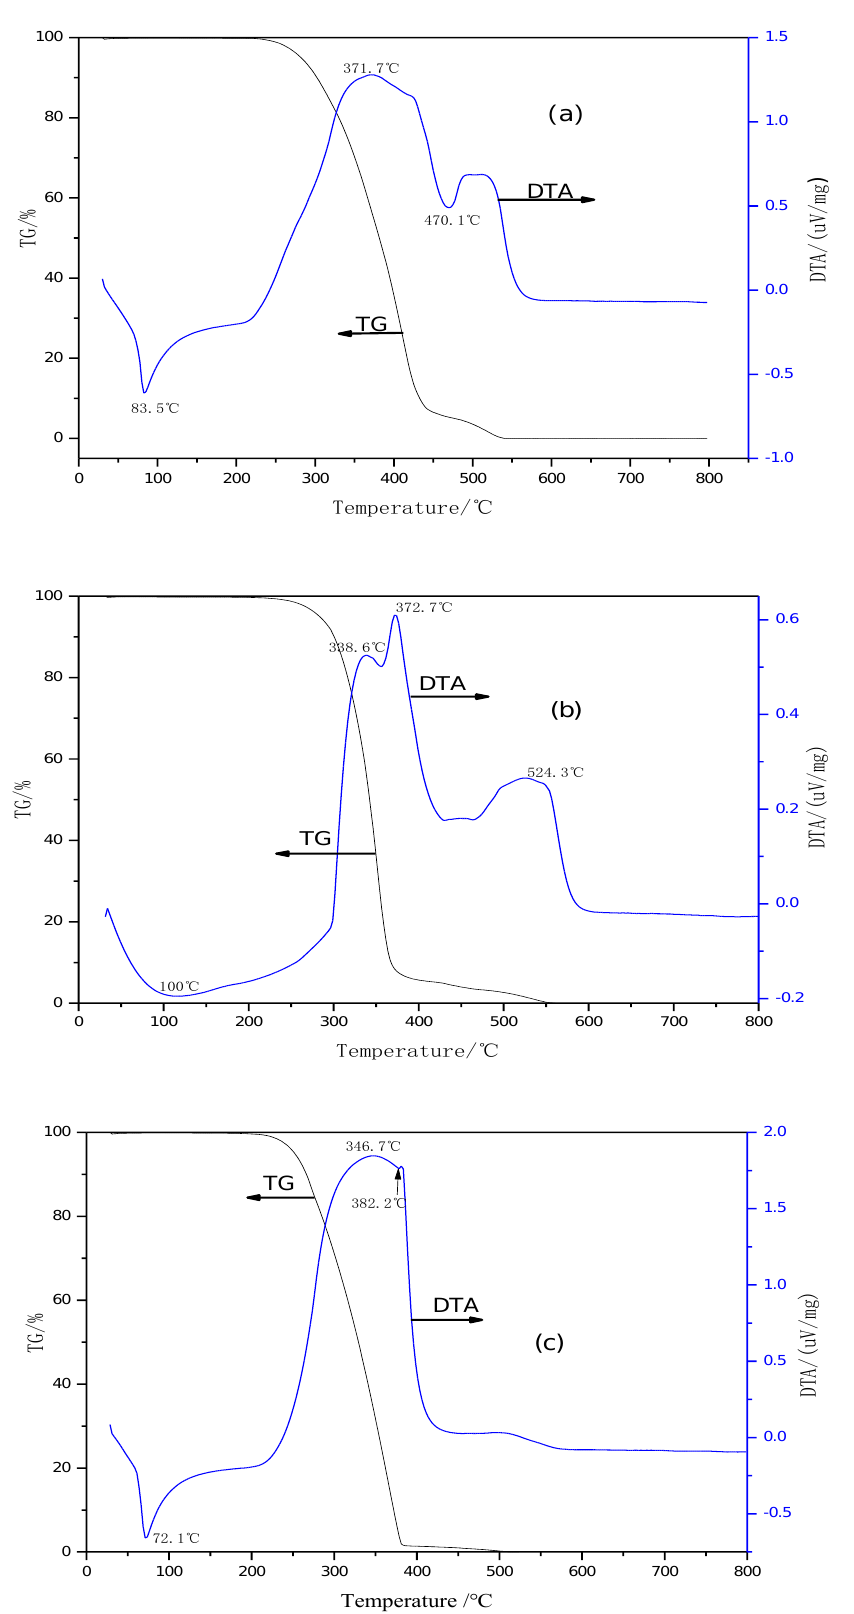
Figure 8. DTA/TG analysis of beeswax ( a ), oleic acid ( b ) and paraffin ( c ).